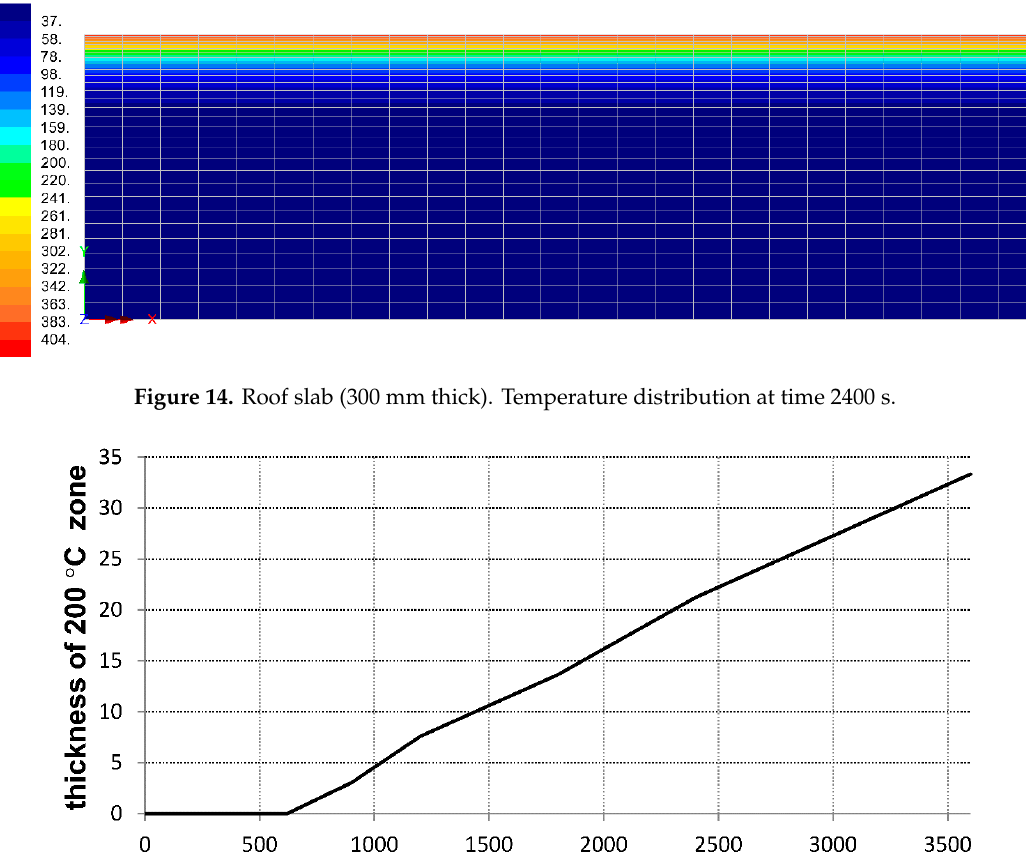
Figure 13. Distribution of compressive strength decrease in the samples no. 008 (continuous line) and